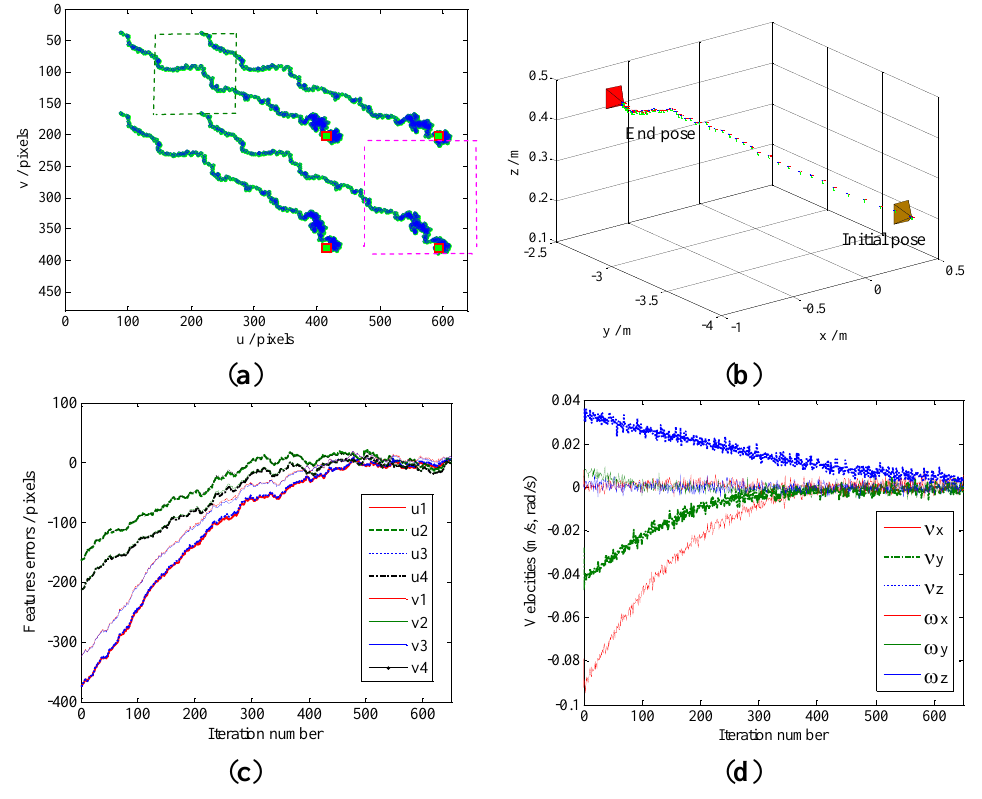
Figure 15. Experimental results obtained by our method for Case 2 translational movement. ( a ) Feature point trajectories; ( b ) Camera trajectory; ( c ) Feature errors; ( d ) Camera